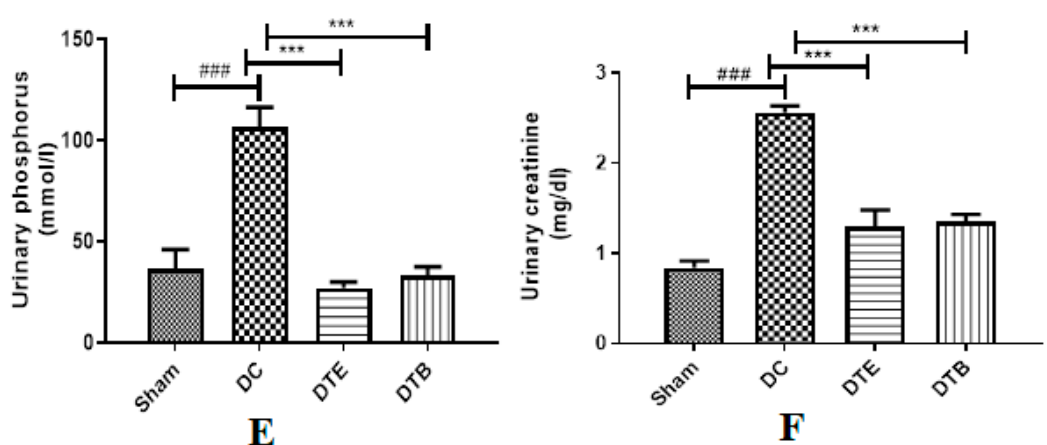
Figure 2. Effect of AKBA on serum as well as urine biochemical parameters in ovariectomized rats. ( A ) Serum calcium. ( B ) Serum phosphorus. ( C ) Serum alkaline phosphatase. ( D ) Urinary calcium. ( E ) Urine phosphorus. ( F ) Urinary creatinine. Data represented are mean ± SEM ( n = 6) analyzed by one